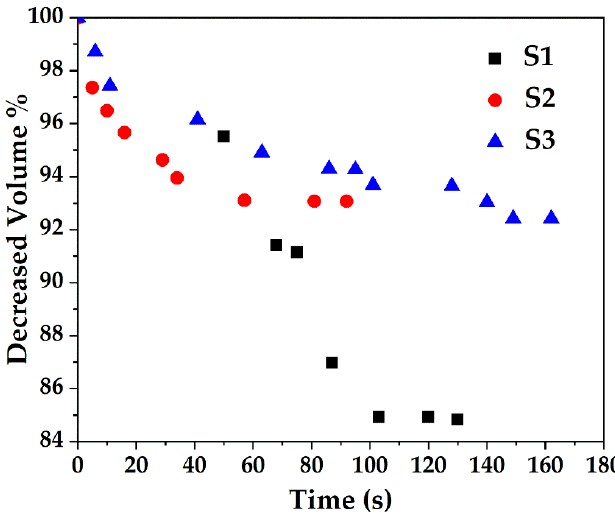
Figure 7. Decrease in volume of Ag@SiO 2 samples of S1, S2 and S3 due to exposure to electron beam as a function of time.